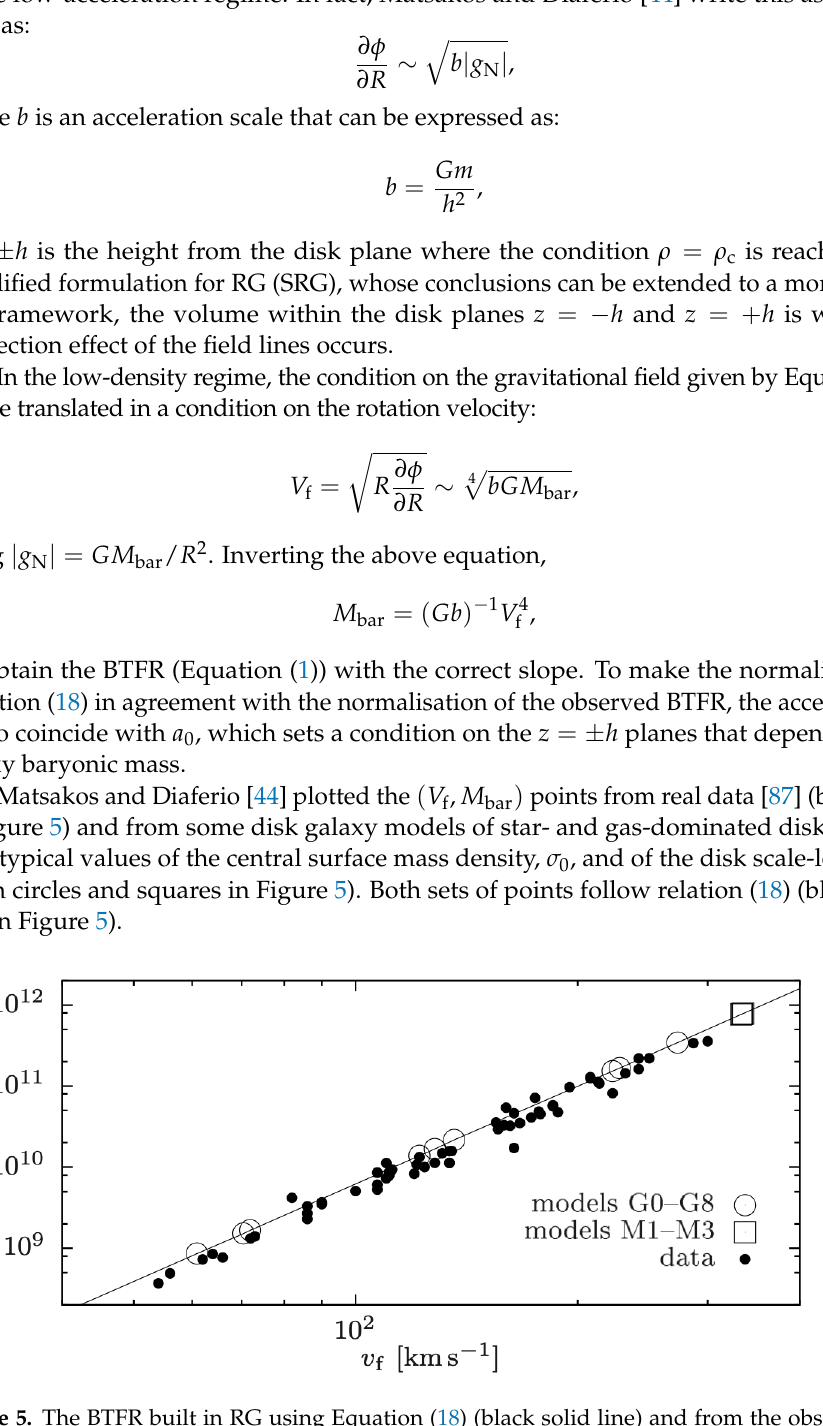
Figure 5. The BTFR built in RG using Equation (18) (black solid line) and from the observational data of [87] (black dots) and some models of star- and gas-dominated disk galaxies (open circles and squares). The RG BTFR properly describes both the data and the model points. The figure is re-adapted from Figure 9 in